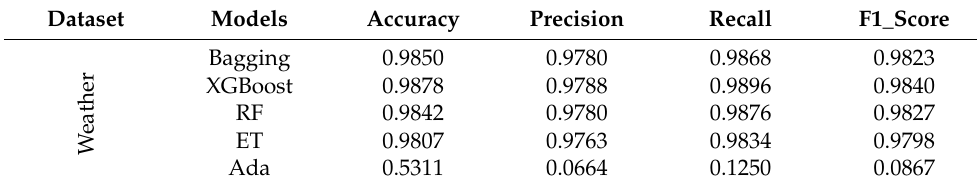
Table 10. The classification report for the Weather dataset.